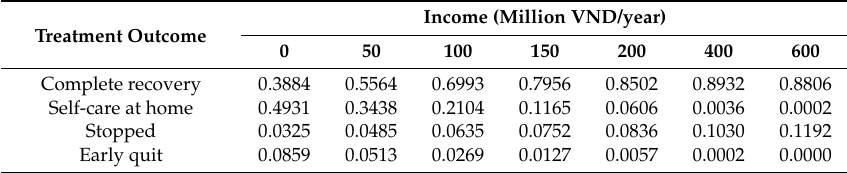
Table 16. Distribution of probabilities of patients’ treatment outcomes against their